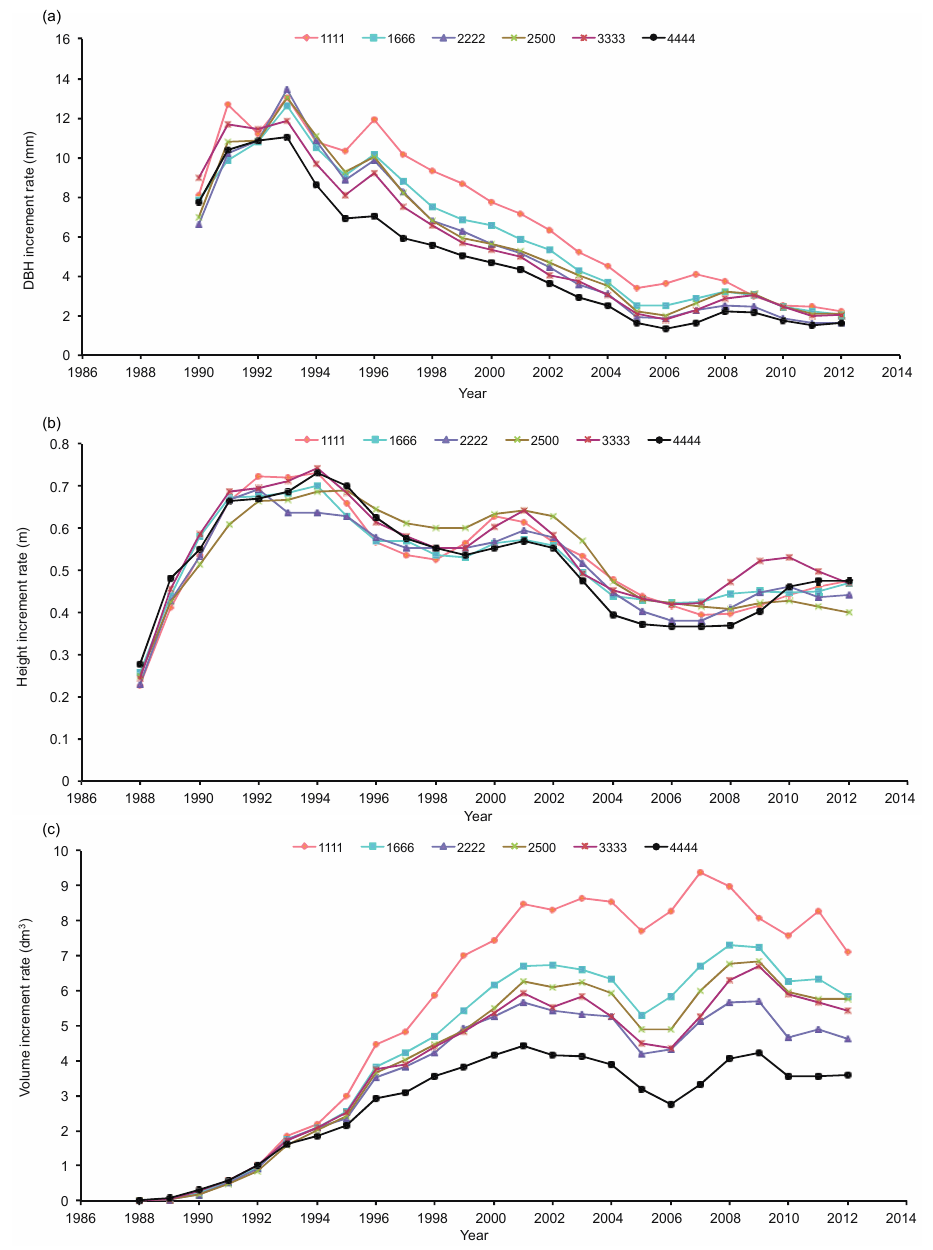
Figure 2. Annual diameter at breast height (DBH) ( a ); height ( b ); and ( c ) stem volume increment rate at different tree spacing for jack pine 25 years following planting in Quebec,